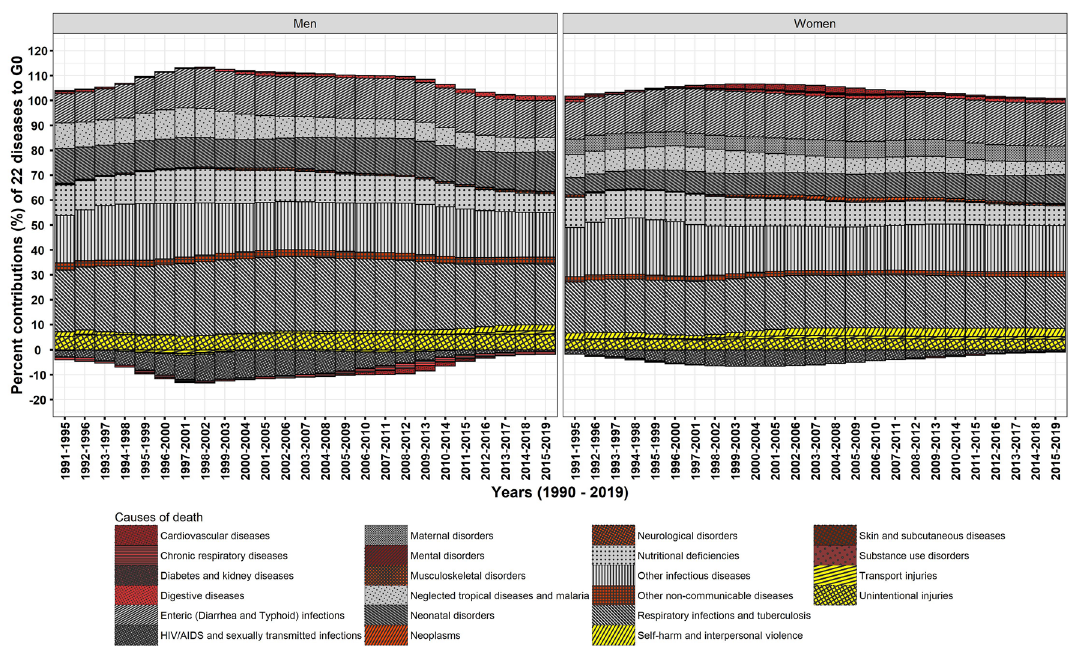
Figure 5. Temporal changes in cause-specific contributions to ΔG 0 , men and women,